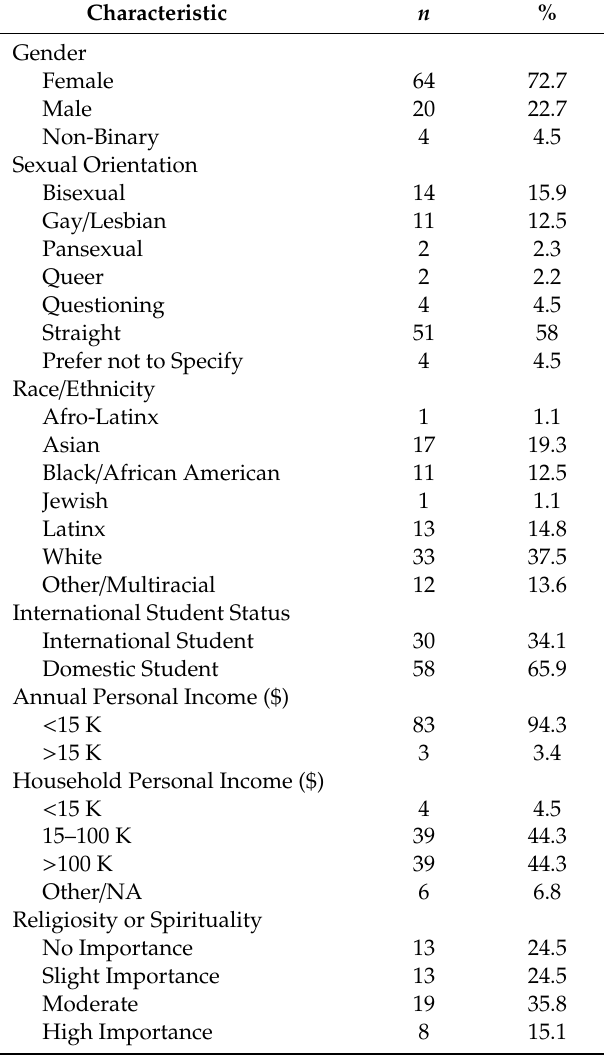
Table 1. Demographic Characteristics of